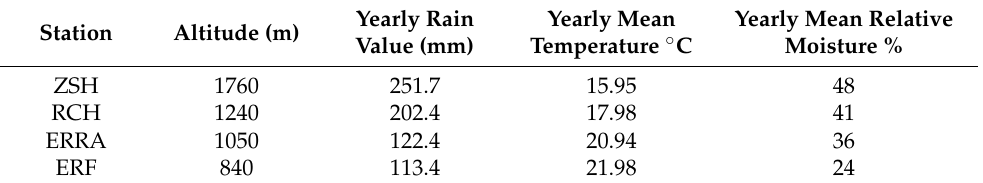
Table 2. Mean climatic parameters for the period December 2019–November 2020 of the four climatic